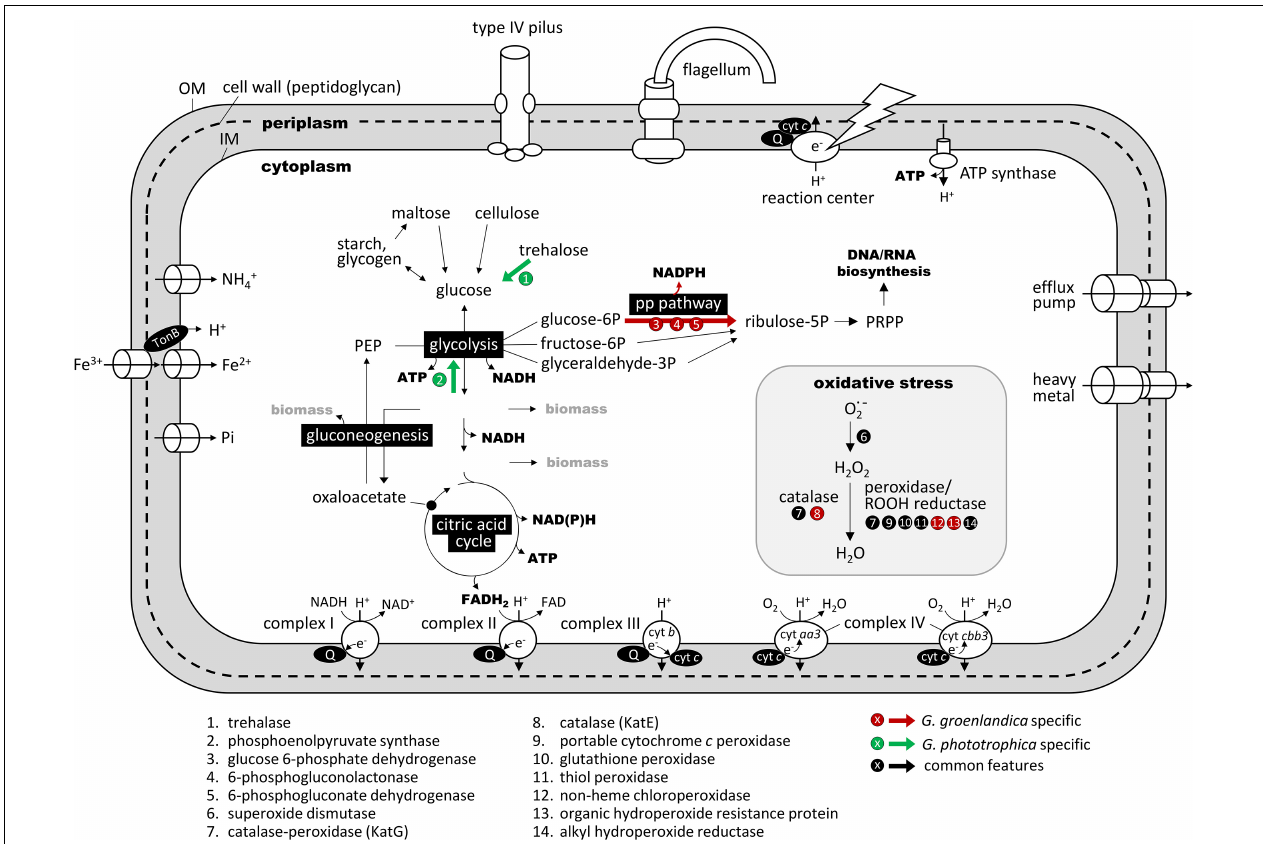
FIGURE 6 | Comparison of key metabolic pathways and functions related to the aerobic photoheterotrophic lifestyle in Gemmatimonas groenlandica and Gemmatimonas phototrophica based on genome annotations. The comparison is based on the “KEGG metabolic pathway reconstruction” function of the RAST (Rapid Annotations using Subsystems Technology) web server (https://rast.nmpdr.org/; Aziz et al., 2008). A complete set of shared and unique genes between these two genomes is shown in Supplementary Table 1 . OM, outer membrane; IM, cytoplasmic membrane; PRPP, phosphoribosyl diphosphate; Q, quinone pool; cyt , terminal cytochrome oxidase; PEP, phosphoenolpyruvate; PRPP, phosphoribosylpyrophosphate; PP pathway, pentose phosphate pathway. Red arrow indicates the pathway that only occurs in Gemmatimonas groenlandica and green arrows are those only present in Gemmatimonas phototrophica . Pathways and functions drawn in black and white are predicted in both genomes. Note that the respiratory complex IV has two types of cytochrome c as terminal electron acceptor. The aa3 -type has a low affinity for O 2 and the cbb3 -type is a high-affinity